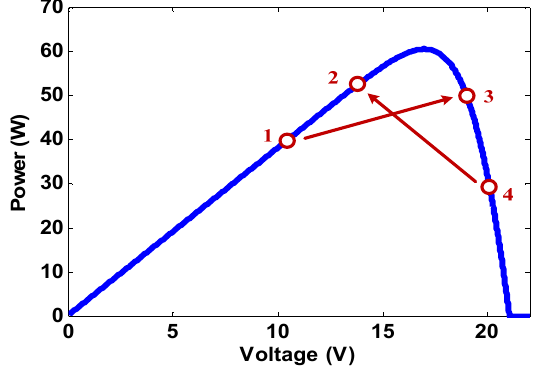
Figure 14. Example of rule conflictions for